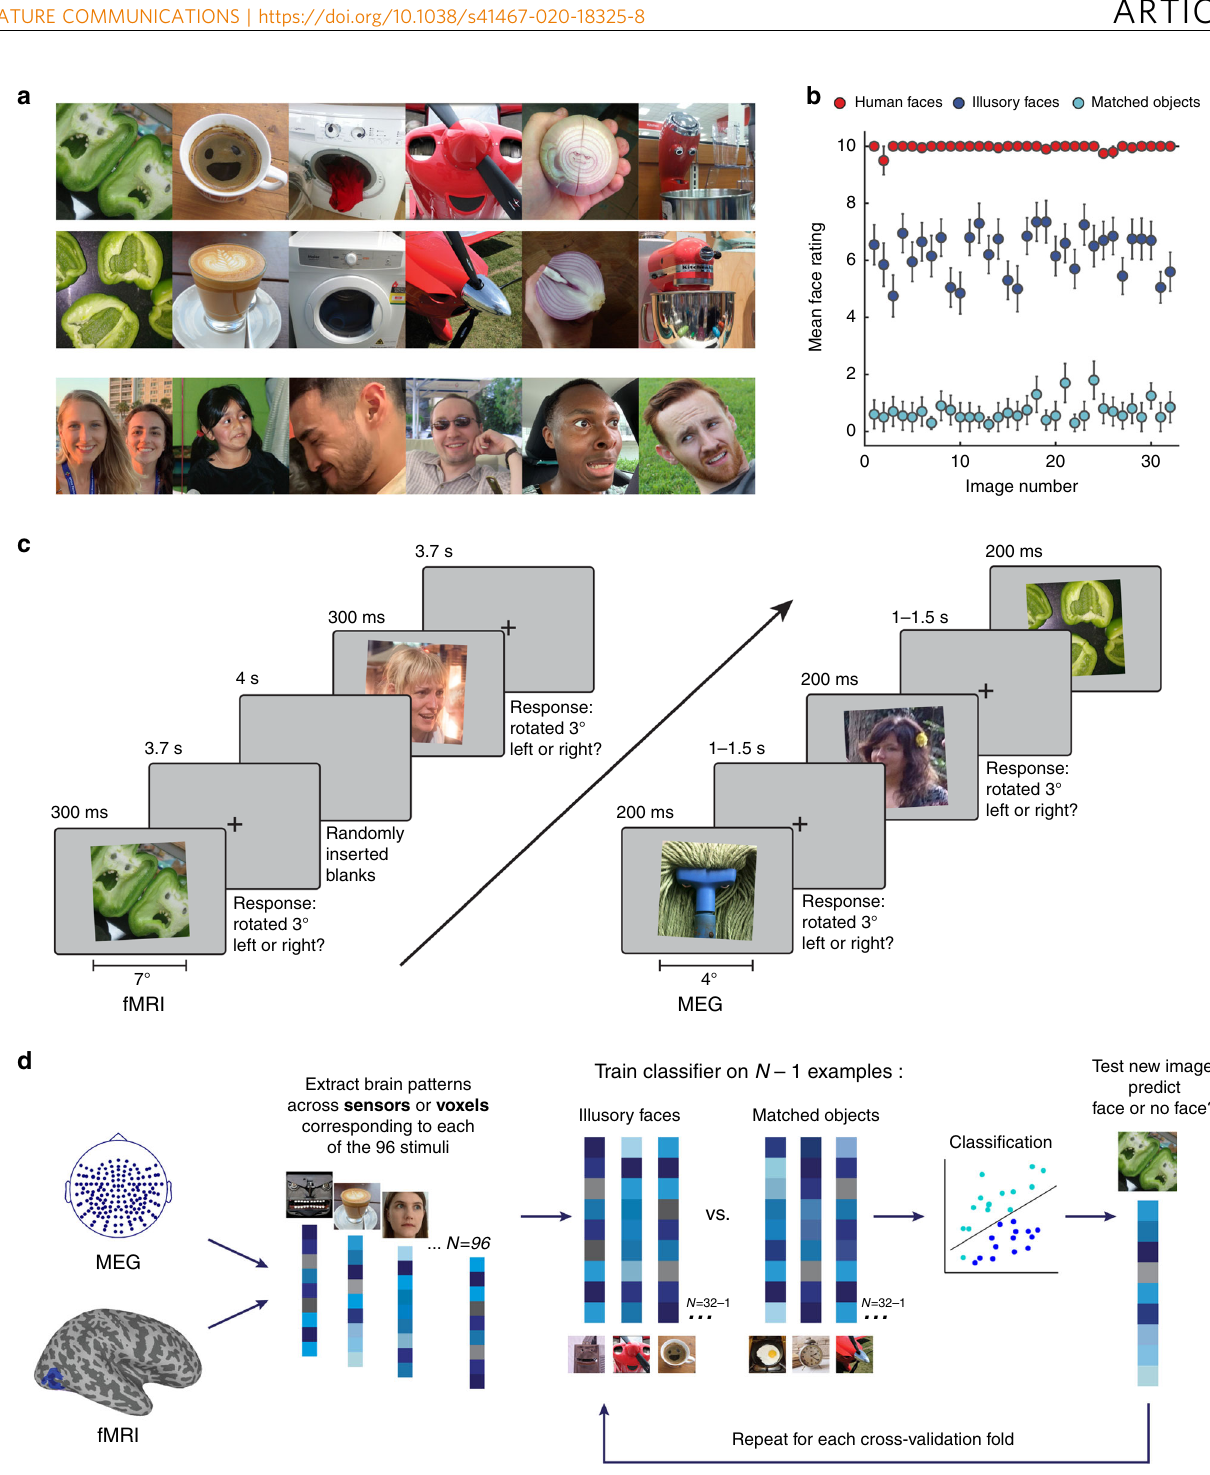
new stimuli, ruling out an explanation based on visual features associated with speci fi c images in the training set. Statistical signi fi cance was assessed using one-sample t -tests (one-tailed) against chance decoding performance (50%). The FDR adjust- ment was made to all reported p values to control for multiple comparisons. In all four regions, human faces could be